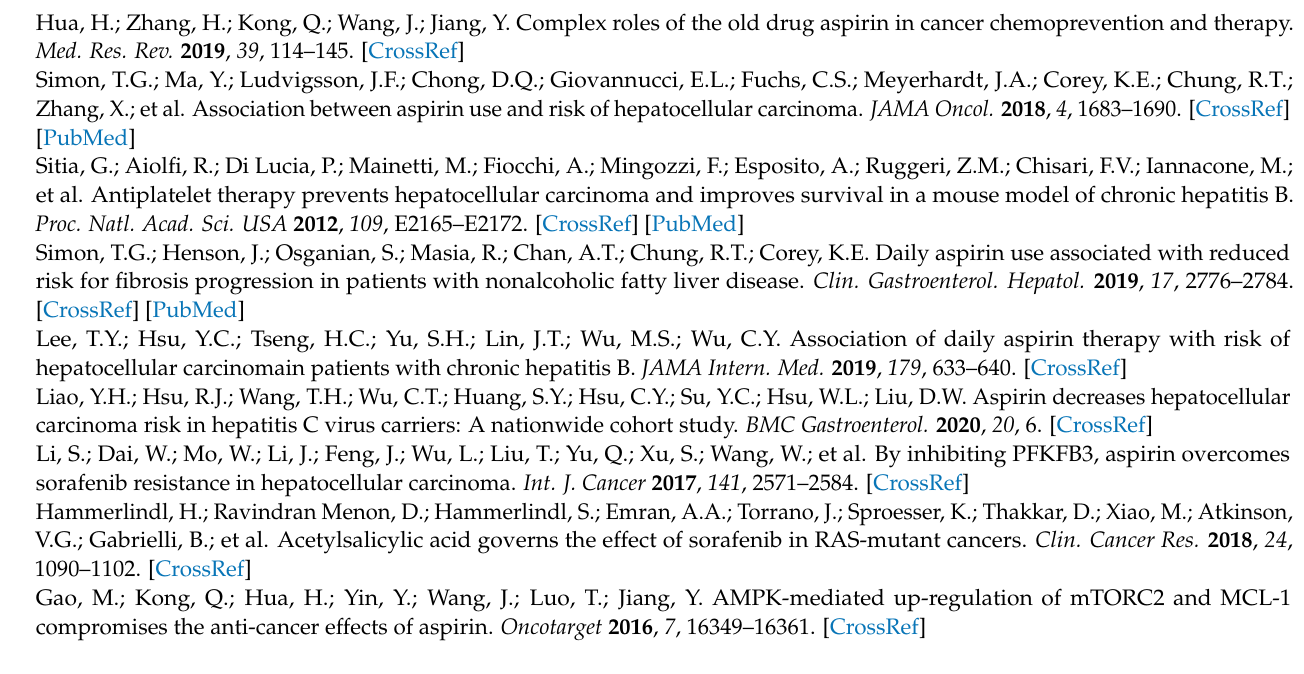
and berbamine. Figure S10: Aspirin does not induce CREB/ATF1 phosphorylation and inhibits CPS1 expression in mouse liver tissues. Table S1: List of the chemicals used in this study. Table S2: List of the antibodies used in this study. Table S3: List of siRNA sequences for RNA interference. Table S4: List of the primer sequences for quantitative reverse-transcription polymerase chain reaction. File S1: The original Western